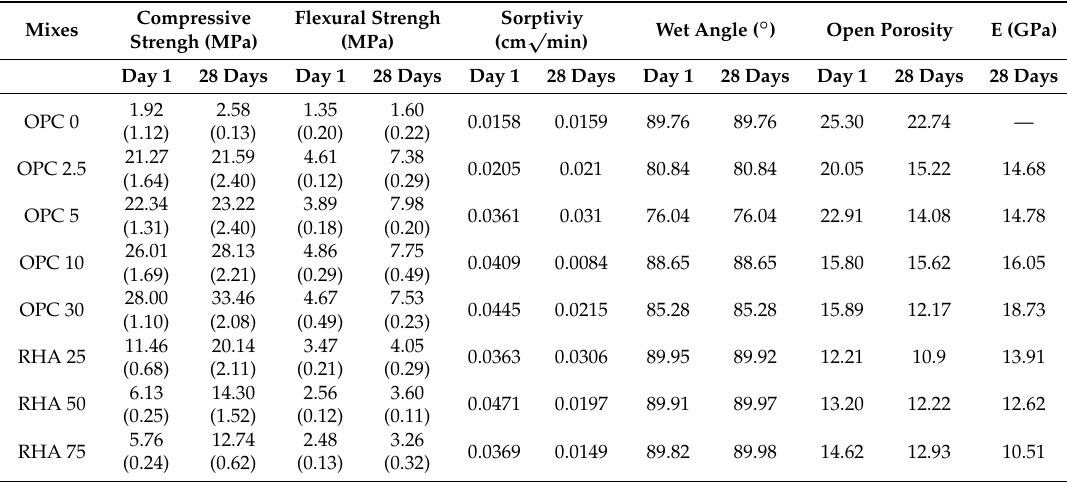
Table 3. Strengths values and physical parameters at 1 and 28 days for mixes of ordinary Portland cement (OPC) and